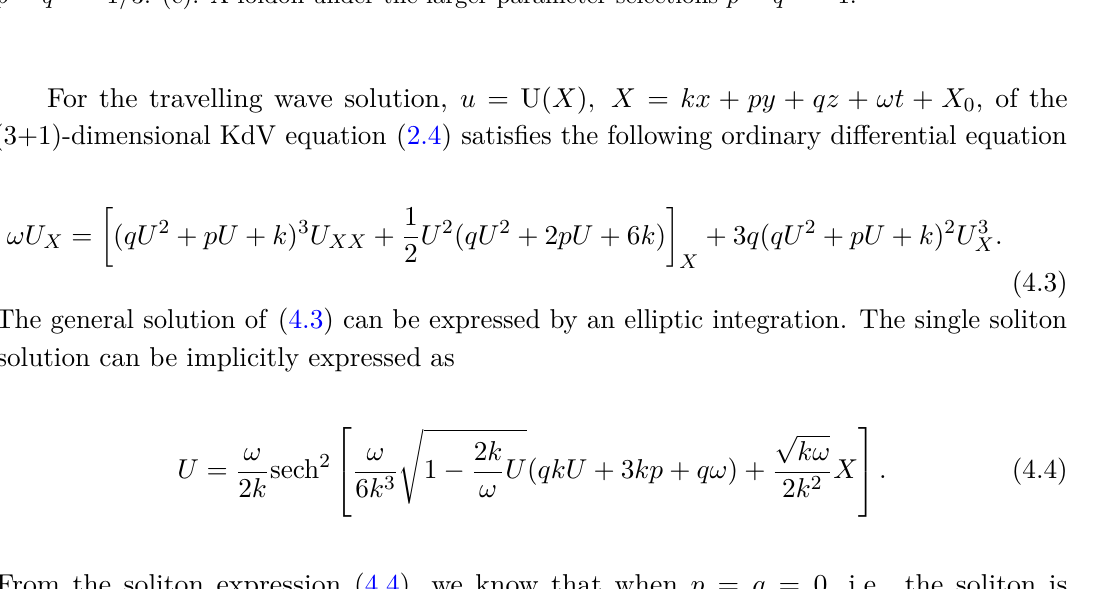
Figure 1 . Different single soliton shapes of (4.4) with the same wave parameters ω = 2 and k = 1 and different deformation parameters p and q . (a). A quasi-symmetric soliton with small deformation parameter selections p = q = 1 / 30 . (b) An asymmetric soliton with parameter selections p = q = − 1 / 3 . (c). A foldon under the larger parameter selections p = q = − 1